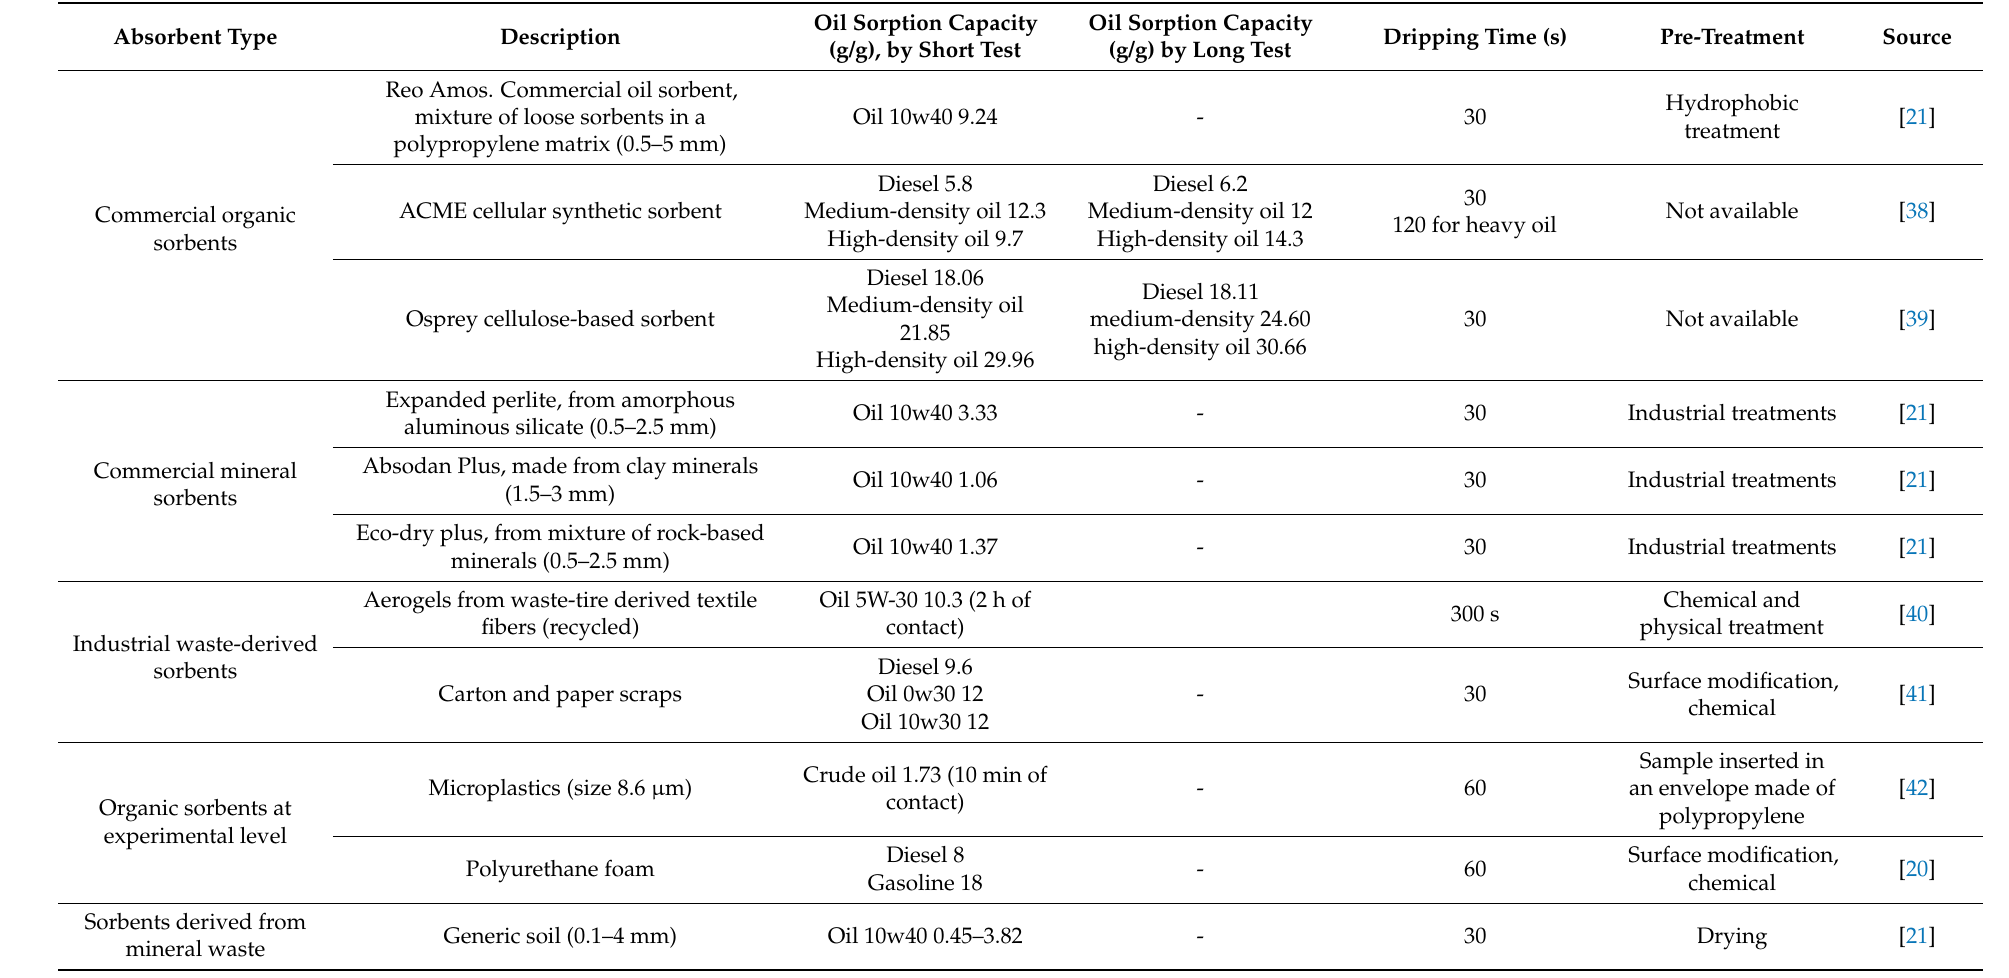
Table 3. Oil sorption capacities reported in the literature for commercial and alternative absorbent